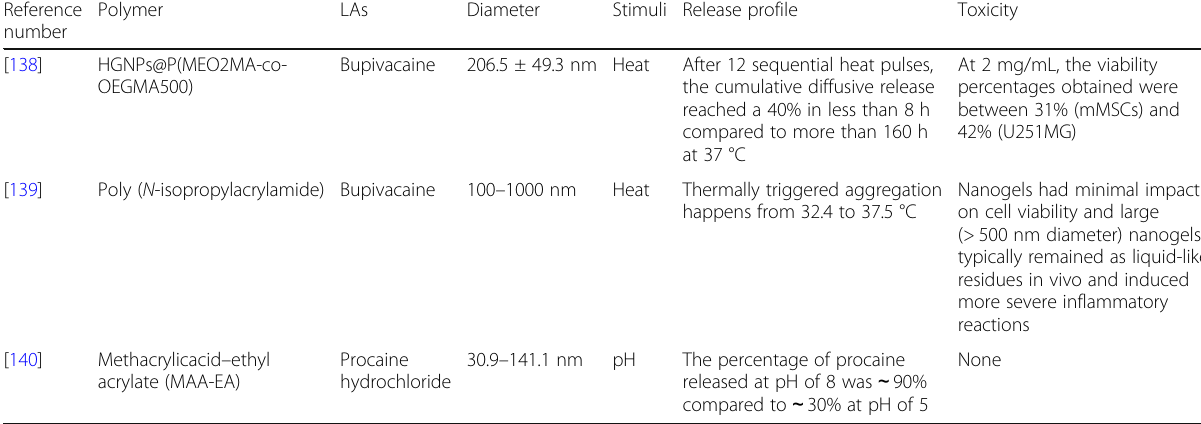
HGNP Hollow gold